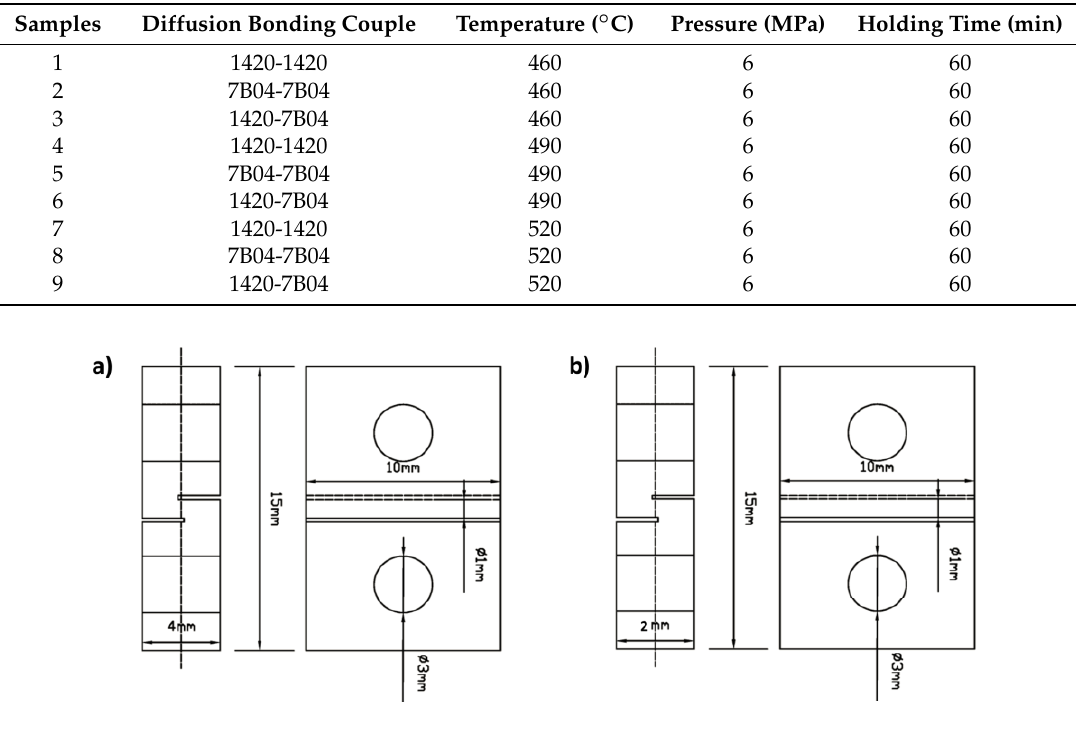
Figure 3. Configuration of shear strength testing pieces (unit: mm): ( a ) For the diffusion bonding joints; ( b ) for the 1420 Al-Li alloy and 7B04 Al alloy base materials. Table 2. Diffusion bonding parameters and bonding couples conducted in the present study.